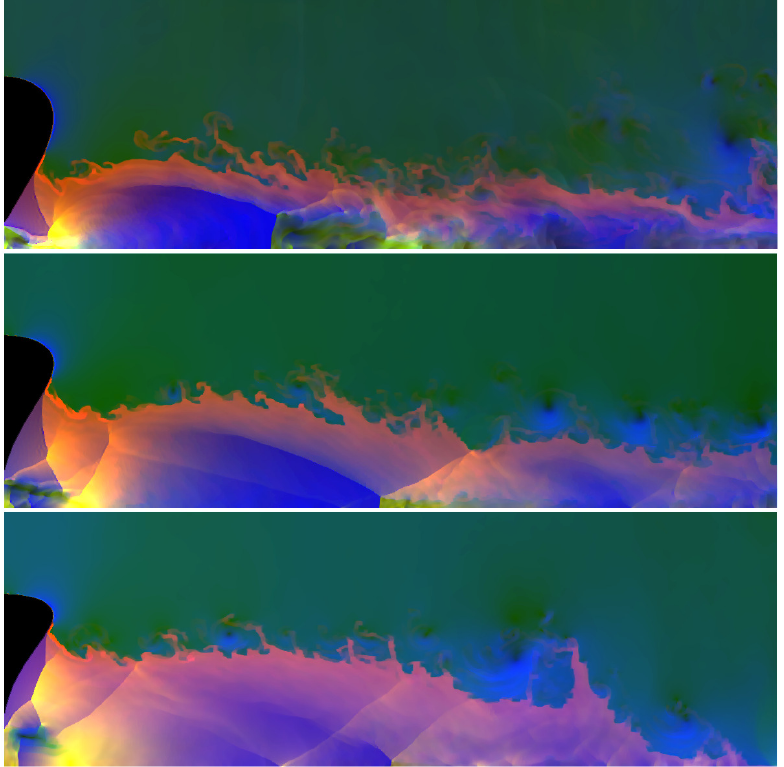
Figure 8. Dependence of the flow pattern on the shape of the ring. Colour coding as before: R = gas density ρ ; G = pressure P ; B = speed v . All simulations Case B; L / L (cid:48) = 4; r − = 0.15; r + = 1.0; γ = 1.2; M 0 = 1.5; snapshot at time t = 1.6. ( Top ): n = 1; b = 1.0. ( Middle ): n = 2; b = 1.25. ( Bottom ): n = 3; b = 1.44. The shock patterns are globally similar in all cases. The flow that starts from a bowl-shaped ring ( Bottom ) is broadest, whereas the ring with a conical inner surface ( Top ) produces a narrower and better collimated